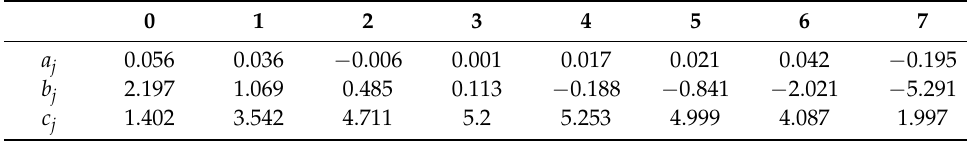
Table 2. Estimated Coefficients of the Left Fractal Curve.